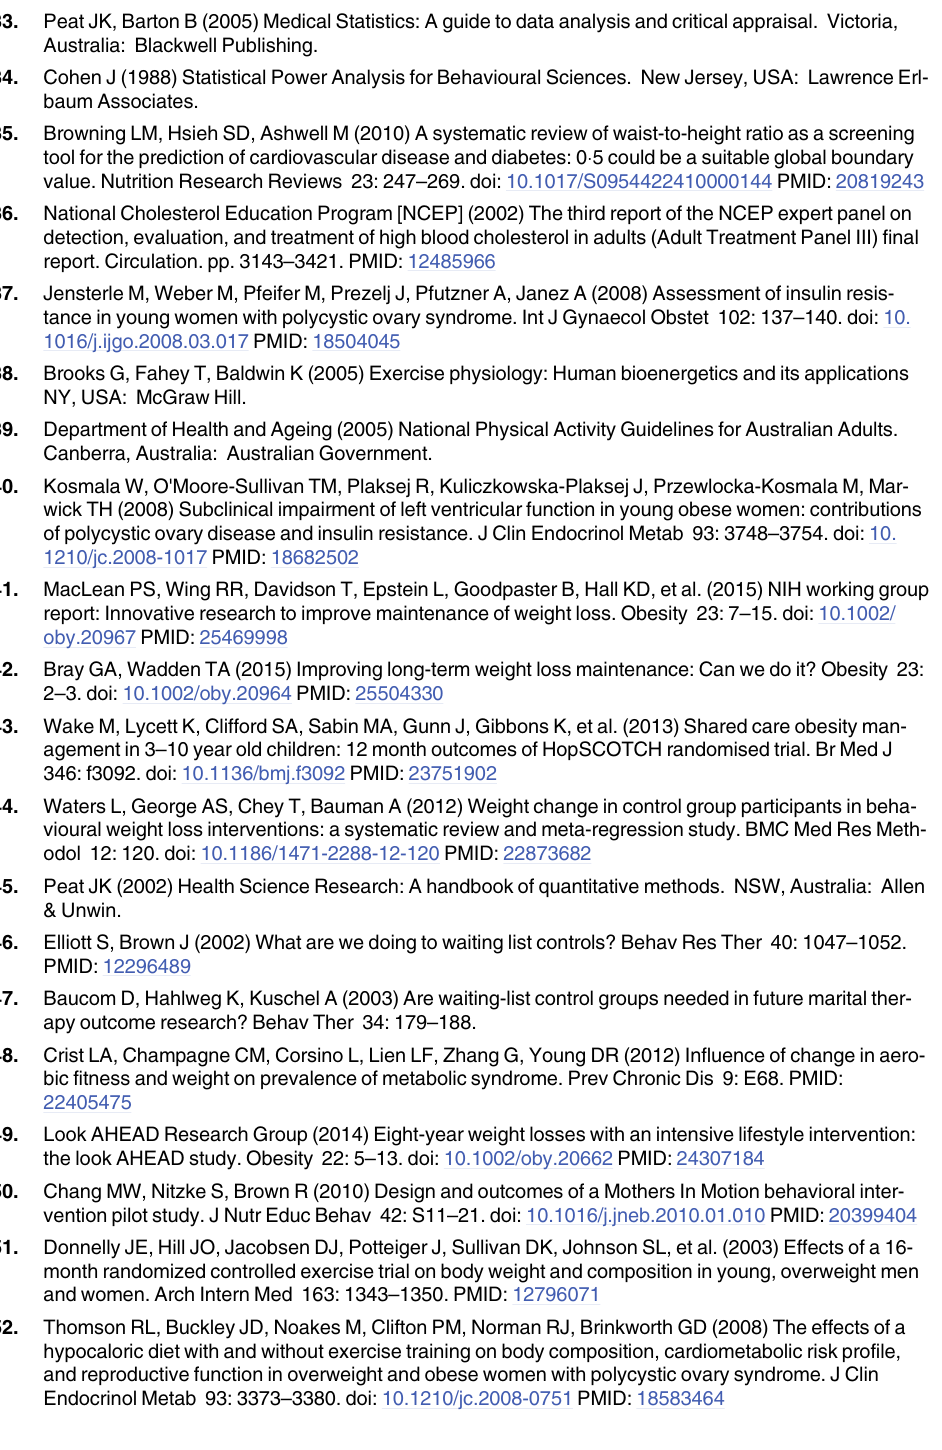
PLOS ONE | DOI:10.1371/journal.pone.0130270 June 26,